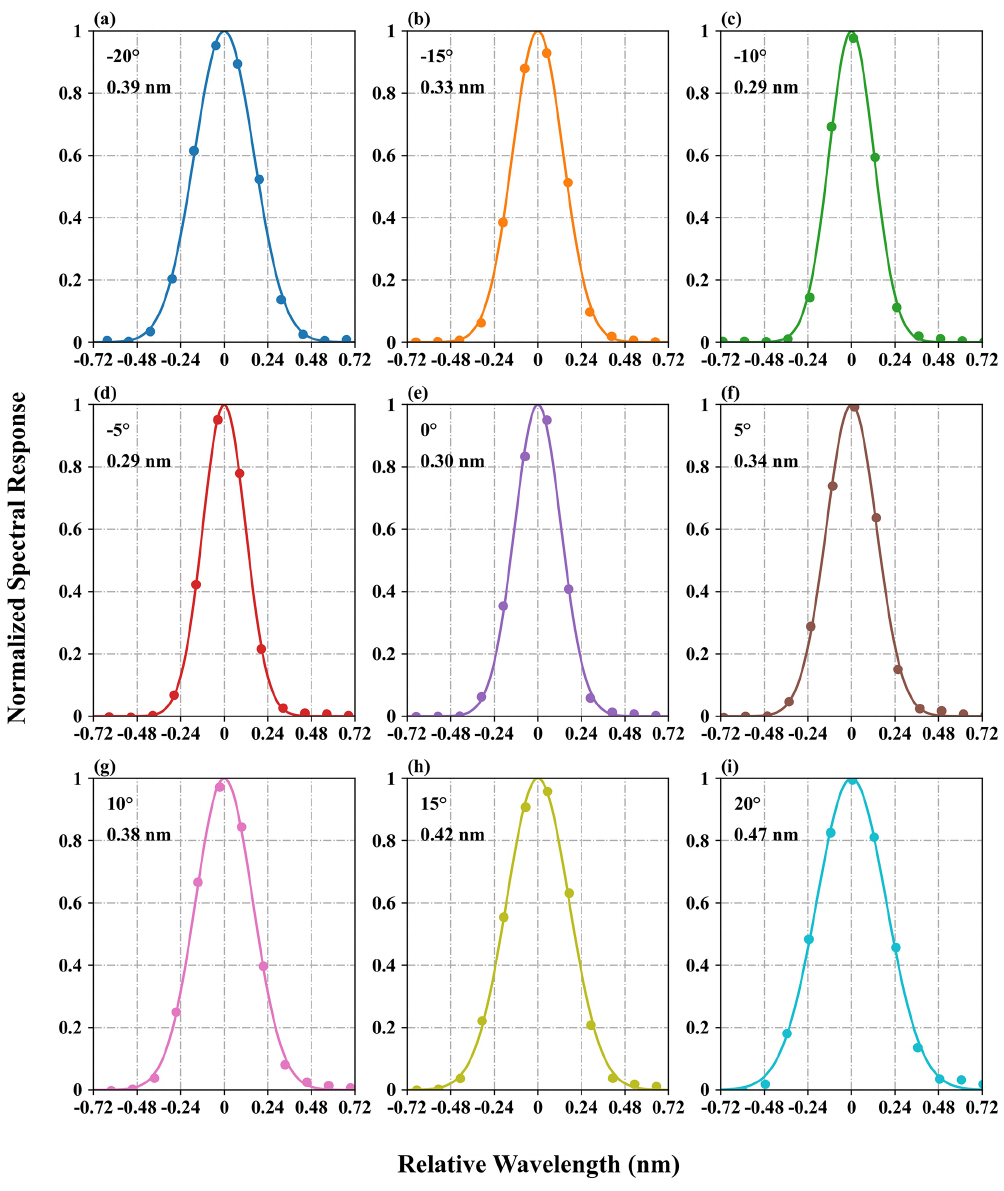
Figure 2. Measured slit functions (dots) at 450.504nm and retrieved slit function shapes (lines) using a symmetric Gaussian function for nine viewing